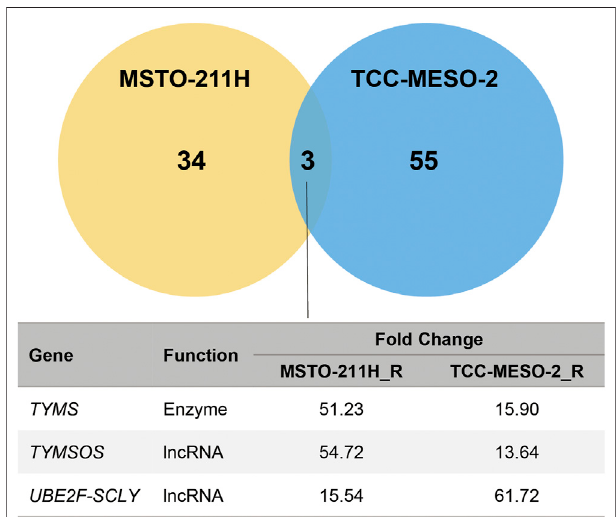
FIGURE 2 | Acquired resistance to pemetrexed signi fi cantly increased the expression of TYMS . RNA-seq in MPM cell lines identi fi ed the differentially expressed genes (DEGs) between parental (MSTO-211H and TCC-MESO-2) and versus resistant (MSTO-211H_R and TCC-MESO-2_R) cell lines, withsigni fi cantdifferenceintheexpressionofthreegenesinbothcells(criteria: |Fold Change| > 2; q-value < 0.05). TYMS , thymidylate synthase; TYMSOS , thymidylate synthase opposite strand; UBE2F-SCLY , ubiquitin-conjugating enzyme E2F and selenocysteine lyase; lncRNA, long noncoding RNA.